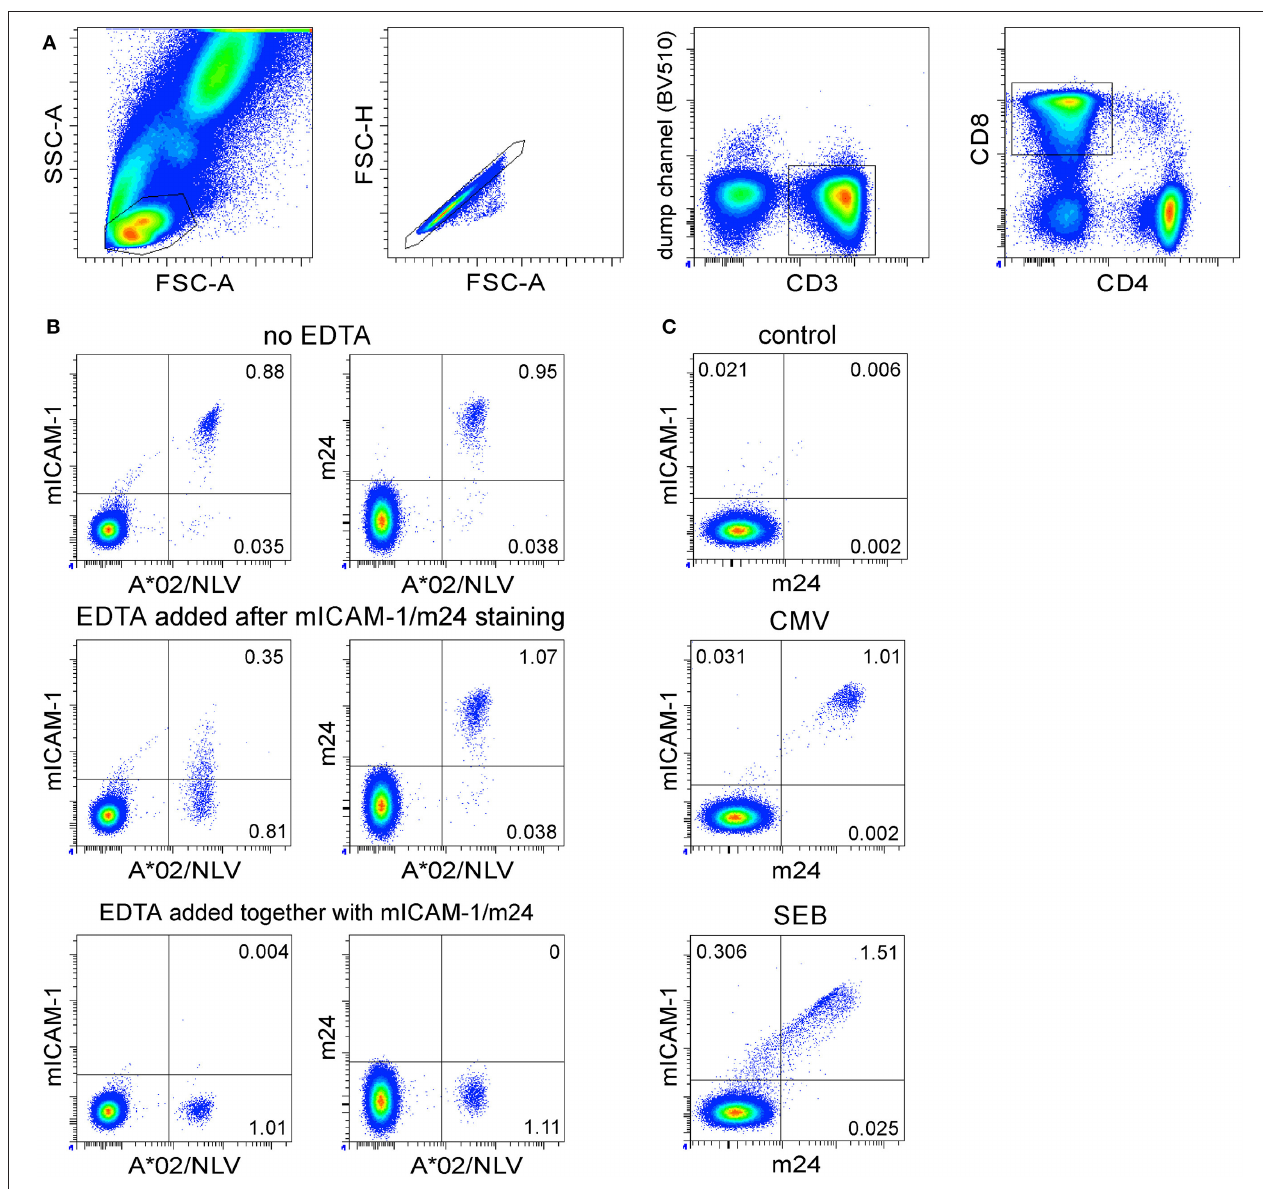
FIGURE 2 | The antigen-specific β 2 -integrin activation on CD8 + T cells can be visualized by either ICAM-1 multimers (without EDTA) or by m24 Ab with or without EDTA treatment. Assessment of WB antigen-specific CD8 + T cells by staining of activated β 2 -integrins. (A) Gating strategy. From left to right, the lymphocyte gate, the FSC-A/H duplet exclusion, the gating of CD3 + events, followed by CD8 + events. (B) The WB from a selected HLA-A*02 + donor was incubated with the NLV peptide for 16min, then either not treated (top) or treated with EDTA after (middle) or at the time of (bottom) the staining with multimers of ICAM-1 or with m24 Ab. Cells were simultaneously stained with A*02/NLV tetramers and thereafter with CD3, CD4, and CD8 Abs. (C) Staining with m24 Ab and ICAM-1 multimers together, without EDTA treatment. Numbers indicate frequencies among CD8 + T cells in %.